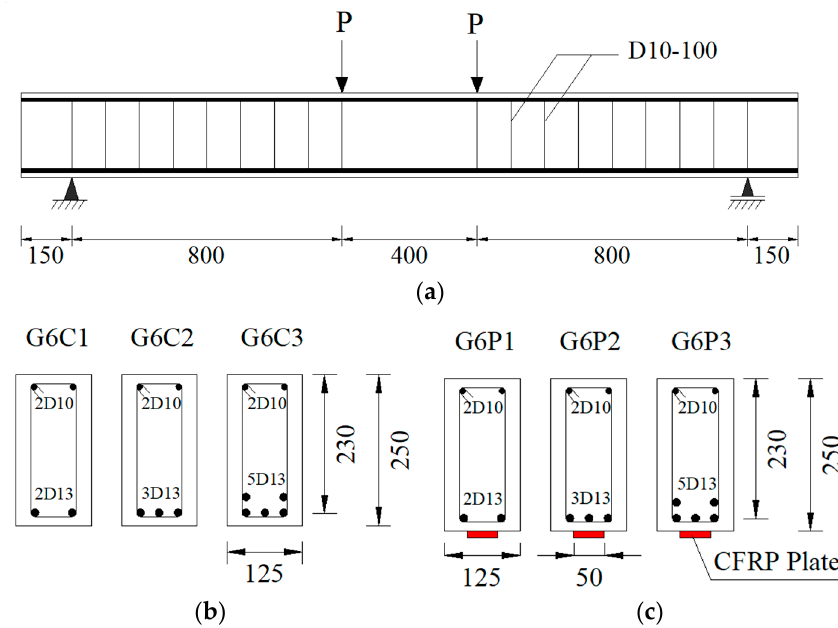
Figure 1. Schematic pictures of the tested beams and their identifications ( a ) beam dimension and loading position, ( b ) cross section of control beams, and ( c ) cross section of plated